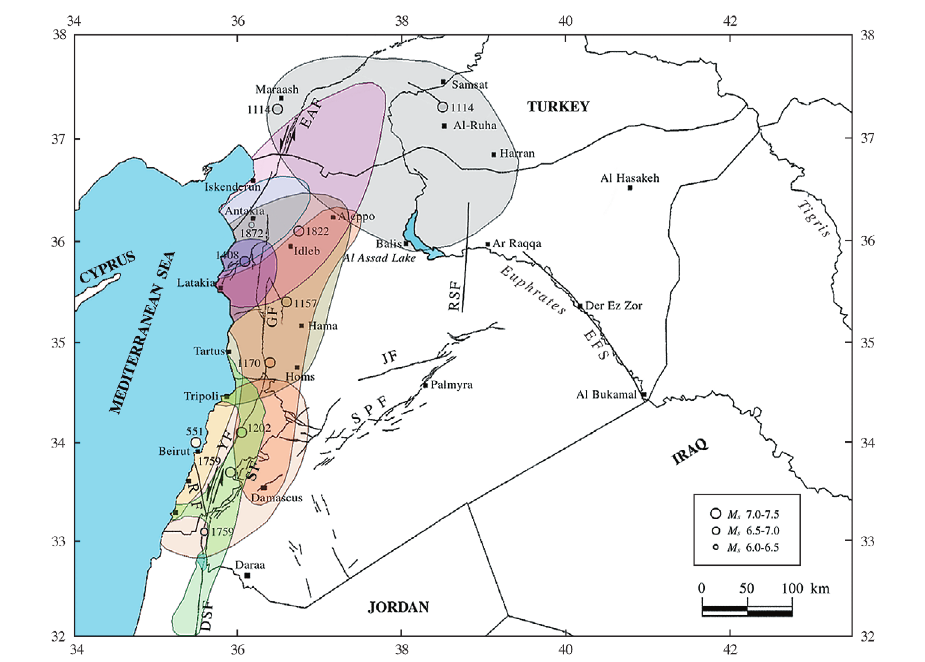
Fig. 23. Map of cumulative main historical earthquake damage distribution in Syria and surrounding region.